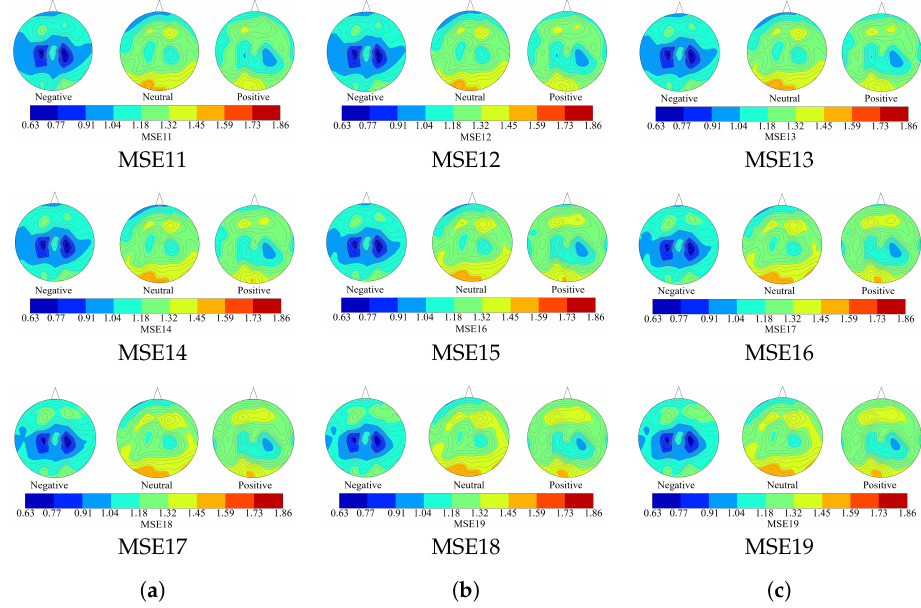
Figure A13. Grand averages of spatial maps of participants’ MSE11s (i.e., 62 MSE11s associated with 62 EEG channels of a participant, per affect) through MSE19s (i.e., 62 MSE19s associated with 62 EEG channels of a participant, per affect). Distribution of MSEs in these spatial maps corresponds to the EEG channels’ arrangement in Figure 1B in the main text (i.e., one MSE value, per EEG